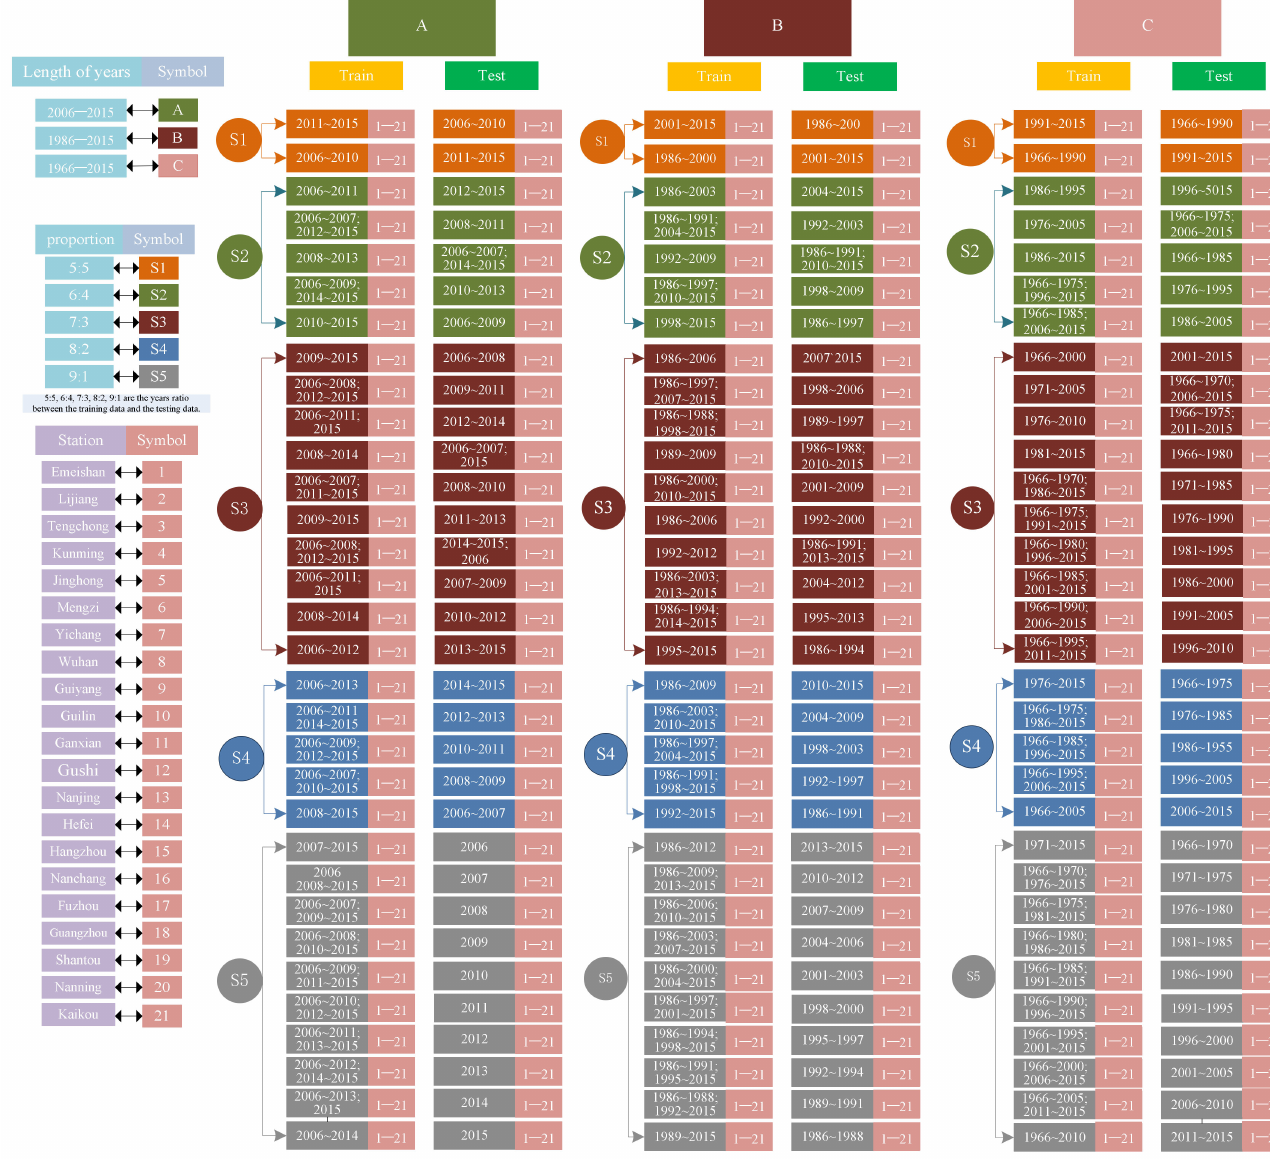
Figure 4. The data splitting strategies, lengths of years, and various cross-validation stages involved in this